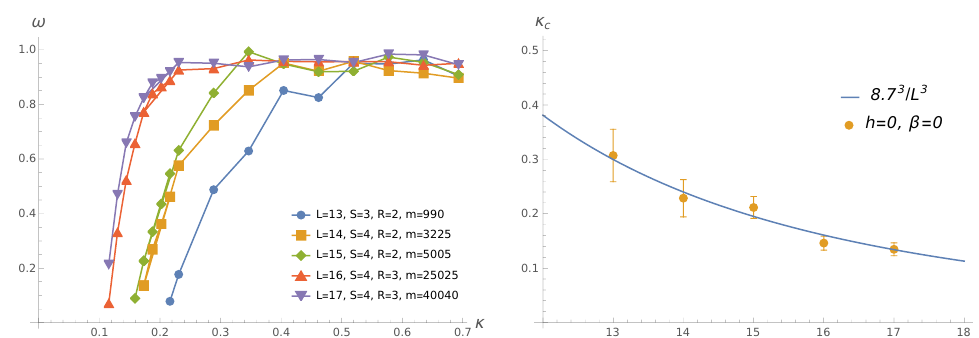
Figure 8 . Left: best fit ω in Brody distribution of level spacings for β = 0 , as κ varies from 0 to 0 . 7 for L = 13 to 17 . Right: cross-over coupling as a function of length L . The curve ∼ 1 /L 3 is shown for